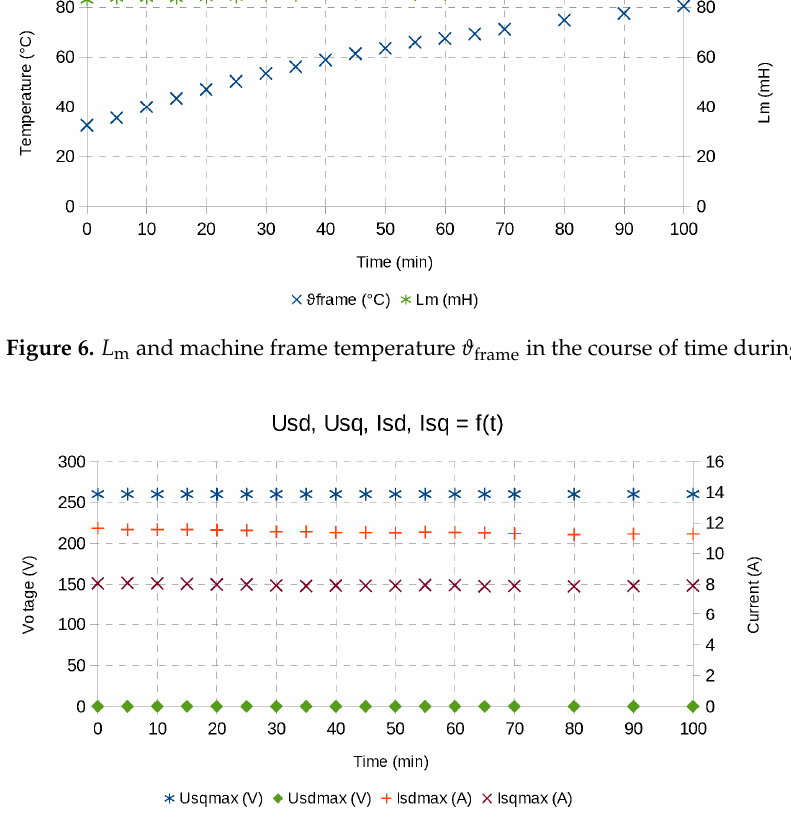
Figure 7. Stator voltage components and stator current components during warming test.